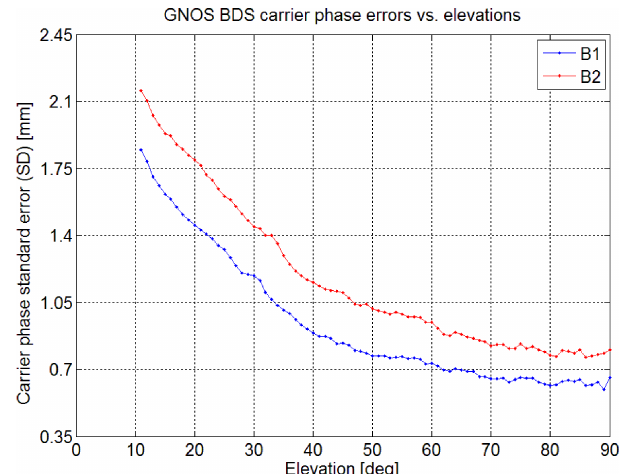
Figure 3. Statistics of FY-3C GNOS BDS carrier-phase SDs (blue for B1 signal carrier phase; red for B2 signal carrier phase) as a function of elevation angle, calculated by using positioning channel measurements.